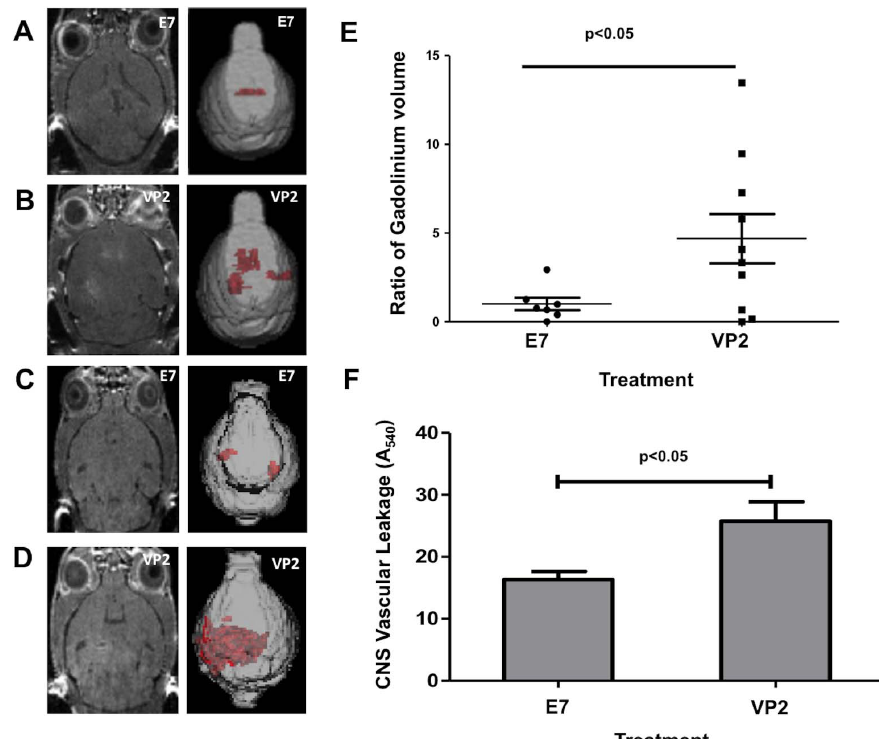
Figure 2. CD8 T cells as sole perforin wielding source are sufficient to induce CNS vascular permeability. The extent of CNS vascular permeability is illustrated by raw image and 3D transparency rendering of gadolinium-enhancing areas from T1-weighted MRI scans in mice administered (A,C) mock E7 control peptide or (B,D) VP2 121–130 peptide. MRI images are separated to show both methods of CD8 + T cell selection (A,B) negative sort or (C,D) positive sort to isolate and transfer CD8 + cells. (E) Quantification of the 3D volume of vascular leakage from all mice (both negative and positive sort) revealed that VP2 121–130 peptide-treated mice having CD8 T cells as the sole perforin-expressing cell type have a significantly more amount of gadolinium leakage (p , 0.05) (n= 5,9 per group). (F) A significant increase in CNS vascular permeability detectable by intravenously injected rhodamine dextran accumulation in brain homogenates was observed in VP2 121–130 peptide-treated animals (n=6) compared to mock E7 peptide-treated animals (n=4) (p , 0.05). Results are depicted as mean 6 SEM.